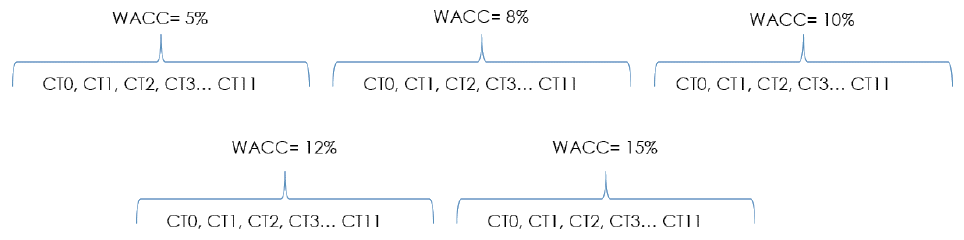
Figure 4. Scenarios modelled.